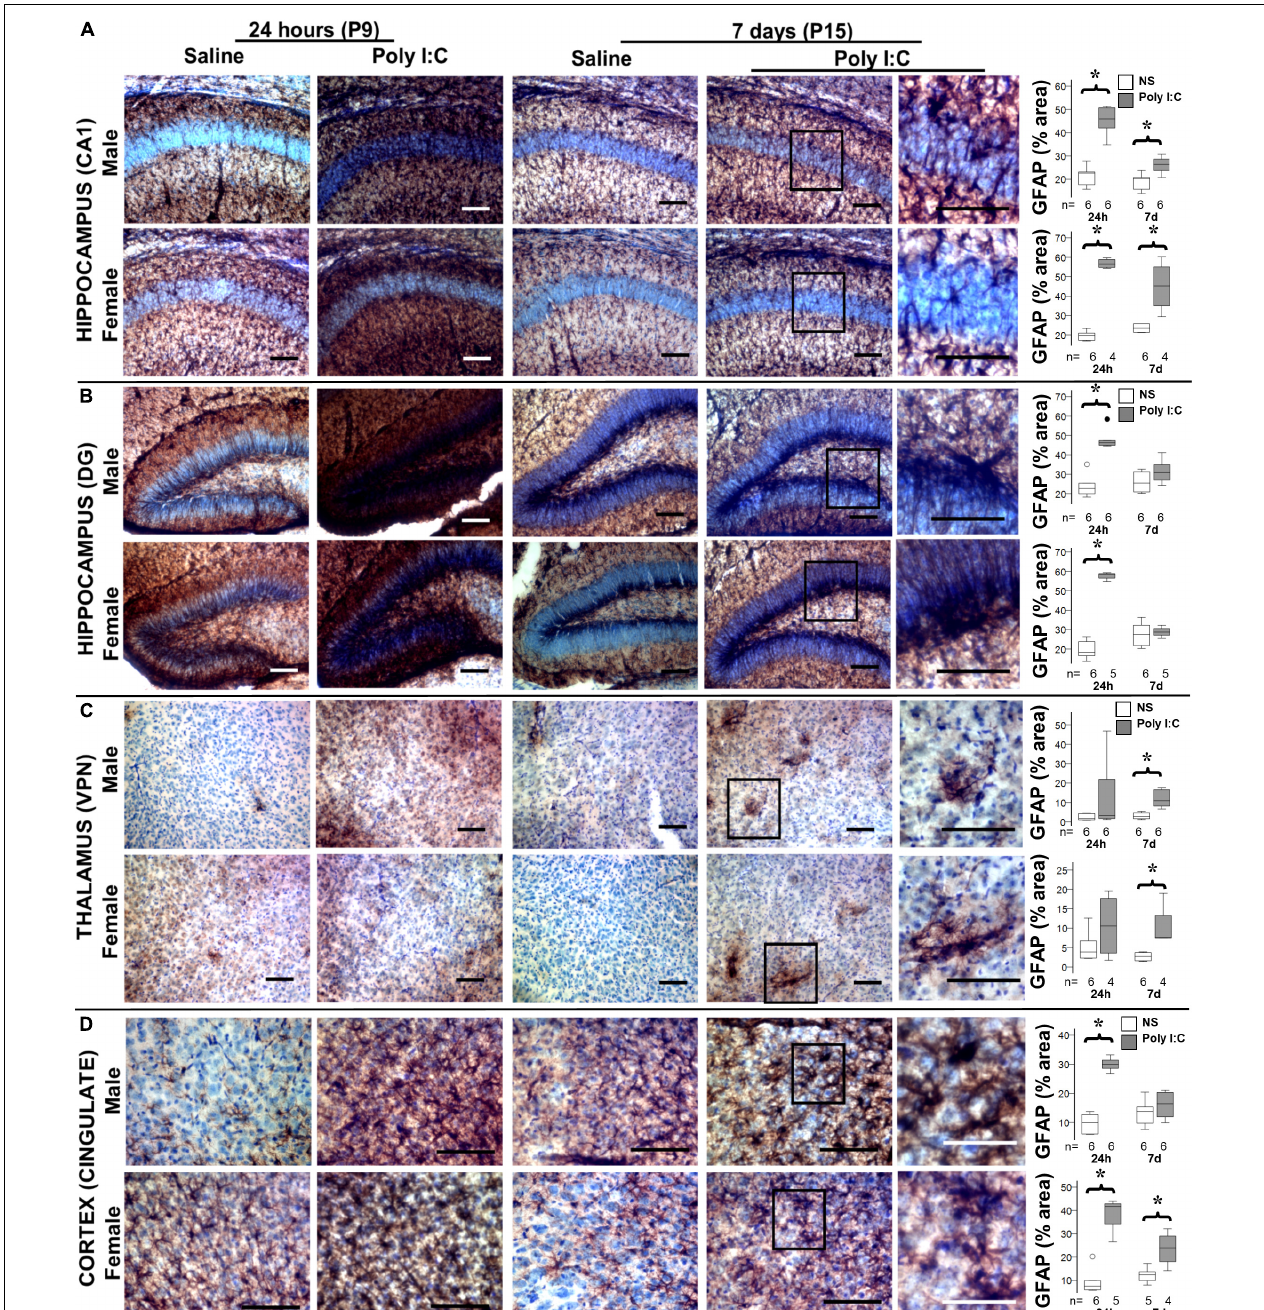
FIGURE 3 | Temporal changes in astrocytic activation after poly I:C exposure at P8. Representative photomicrographs of GFAP immunoreactivity in the CA1 (A) and dentate gyrus (DG, B ) subfields of the hippocampus, ventroposterior nuclei (VPN) of the thalamus (C) , and cingulate cortex (D) of male and female mice at 24 h and 7 days after treated with normal saline or poly I:C. High magnification details are provided for 7 days after poly I:C. In all panels, bar represents 100 µ m, with the exception of the detail higher magnification panel for the cingulate cortex at 7 days after poly I:C, where bar represent 50 µ m. Semi-quantitative analyses of percent area of GFAP immunostaining per sex and region of interest are shown using box and whiskers plots, where boxes are limited by the 75 th and 25 th percentiles (IQR) and whiskers are limited by the last data point within 1.5 times the IQR from the median (continuous line inside the box). Data from male (top) and female (bottom) mice at 24 h and 7 days after treatment with NS (white boxes) or poly I:C (gray boxes) are shown. ◦ , outlier (between 1.5 and 3 times the IQR); • , extreme ( > 3 times the IQR); ∗ p < 0.05 ( n = 6/ group). Twenty-four hours after poly I:C, significant astrocytic activation was observed in the hippocampus (CA1 and DG subfields) and cingulate cortex. At 7 days after poly I:C, astrocytic activation greatly diminished with the exception of the VPN of the thalamus, demonstrating greater evidence of astrocytosis at 7 days than at 24 h after poly I:C. No sex-specific differences were observed. Detailed information about percent area of GFAP immunoreactivity in each area of interest is provided in Table 2